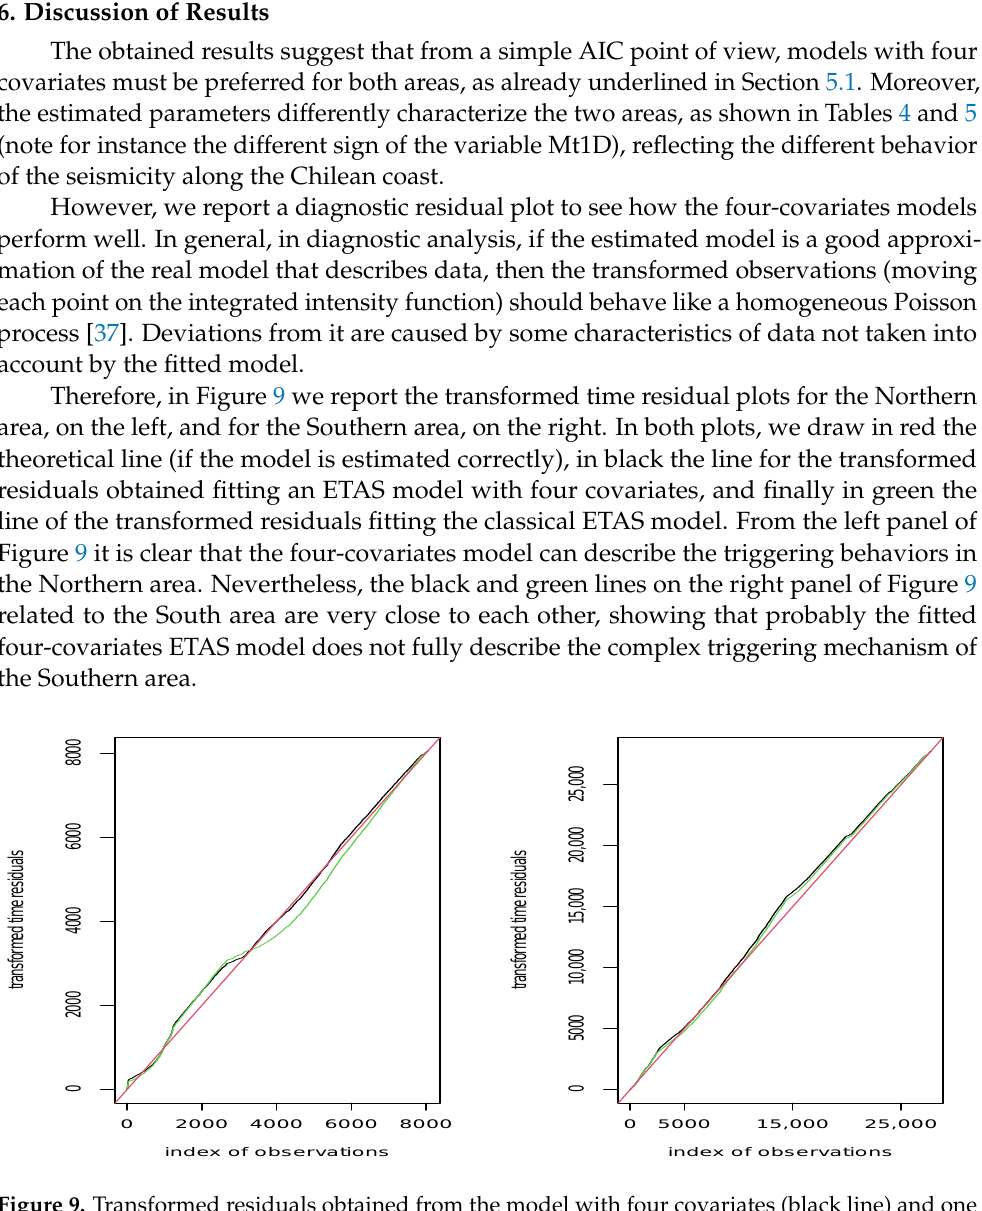
Figure 9. Transformed residuals obtained from the model with four covariates (black line) and one covariate (green line), for the Northern area ( left panel) and the Southern Area ( right panel). The red line is the theoretical